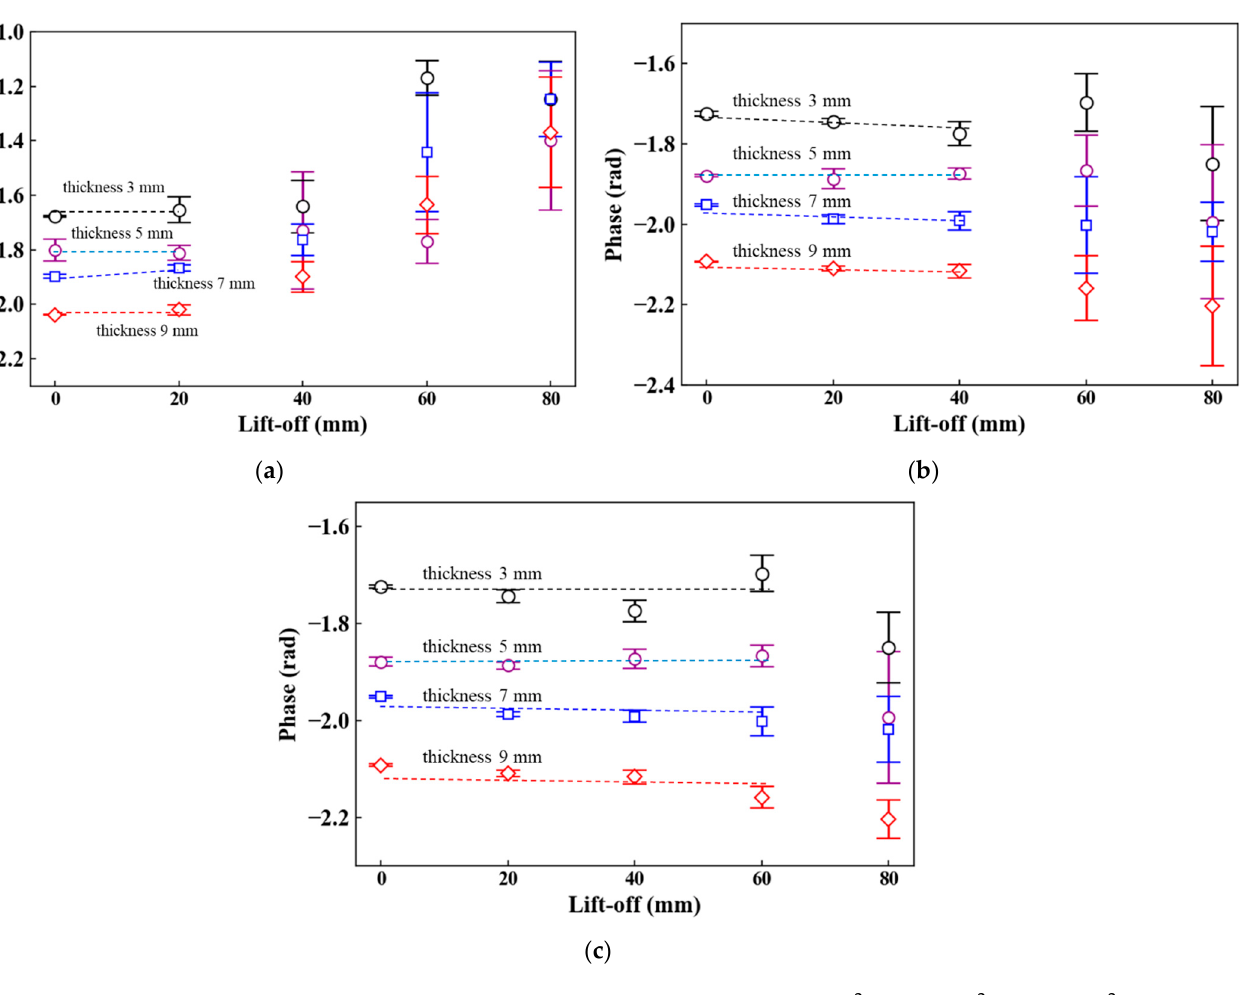
Figure 8. Lift-off dependence of phase (coil area: ( a ) 50 mm 2 , ( b ) 70 mm 2 , ( c ) 100 mm 2 ).